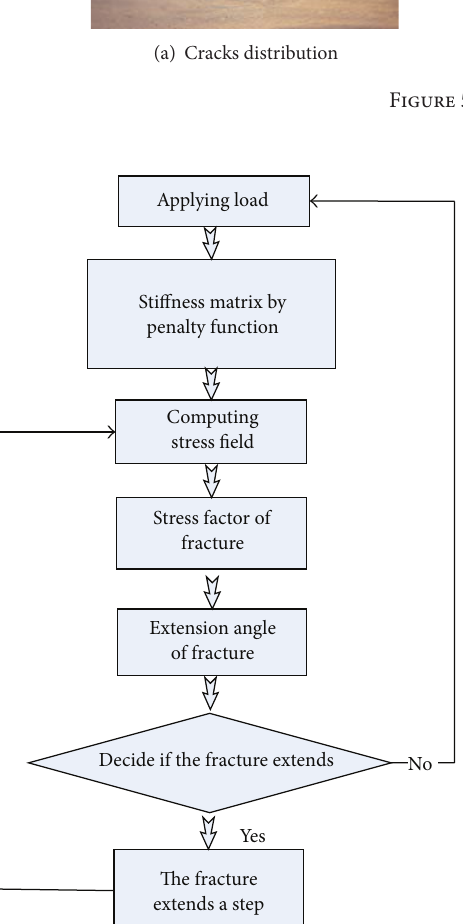
Figure 6: Numerical procedure of the extended finite element method (XFEM).